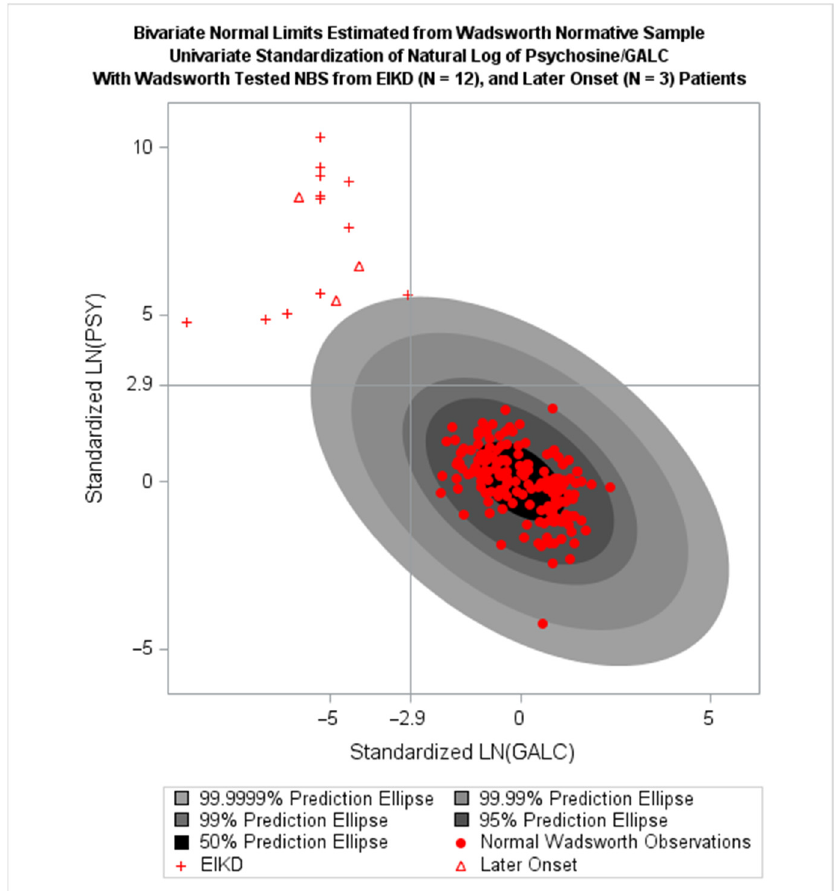
Figure 1. BVNL estimated from Wadsworth Normative Sample (red circles; N = 166), with Wadsworth tested NBS from EIKD (red crosses; N = 12) and Later Onset (red triangles; N = 3) Age at onset ranged from birth to six months in EIKD and 11 to 29 months in Later Onset. Points in the upper left quadrant and outside the ellipse represent positive screens for